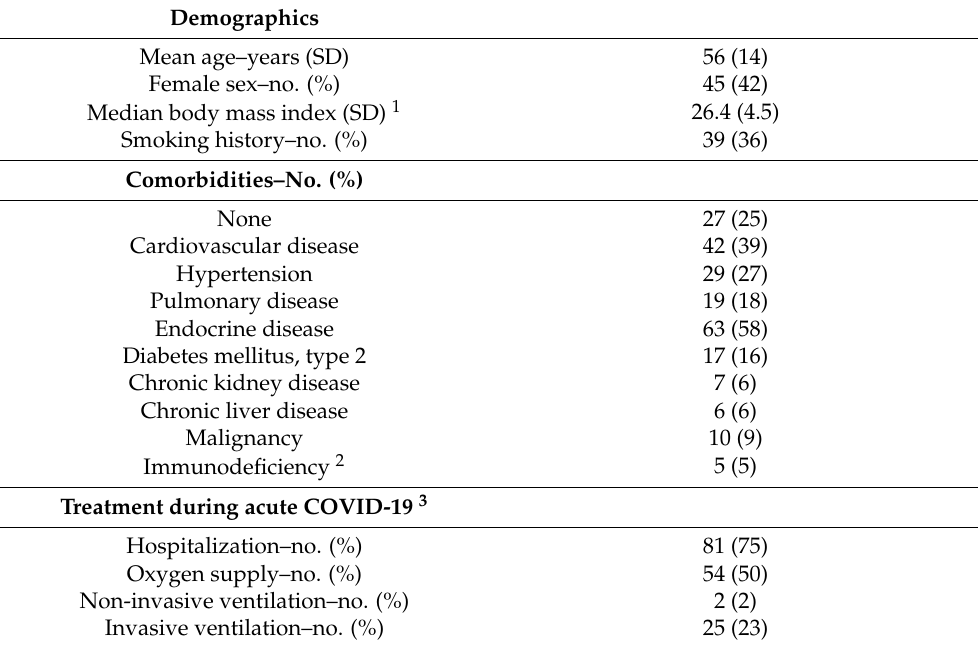
Table 1. Characteristics of the study cohort (N =